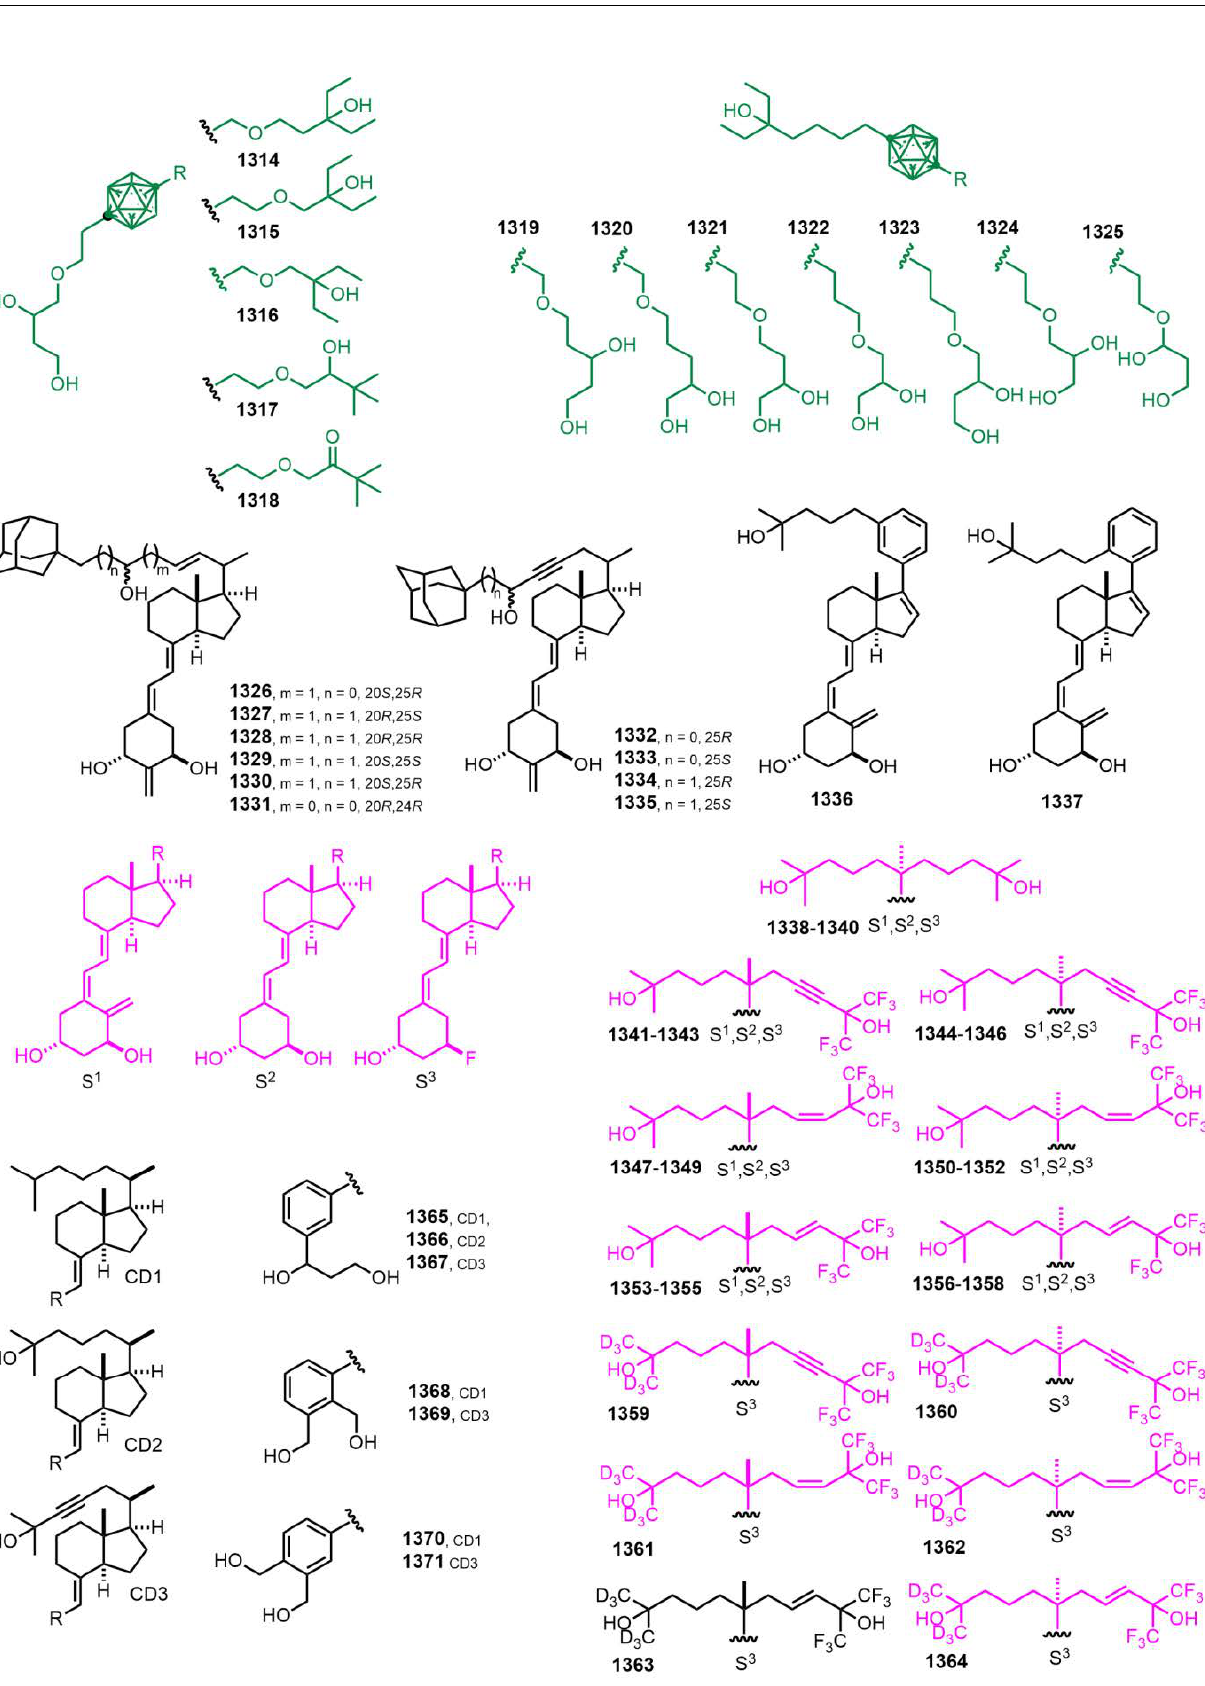
Figure 23. (2014) [317 – 321].